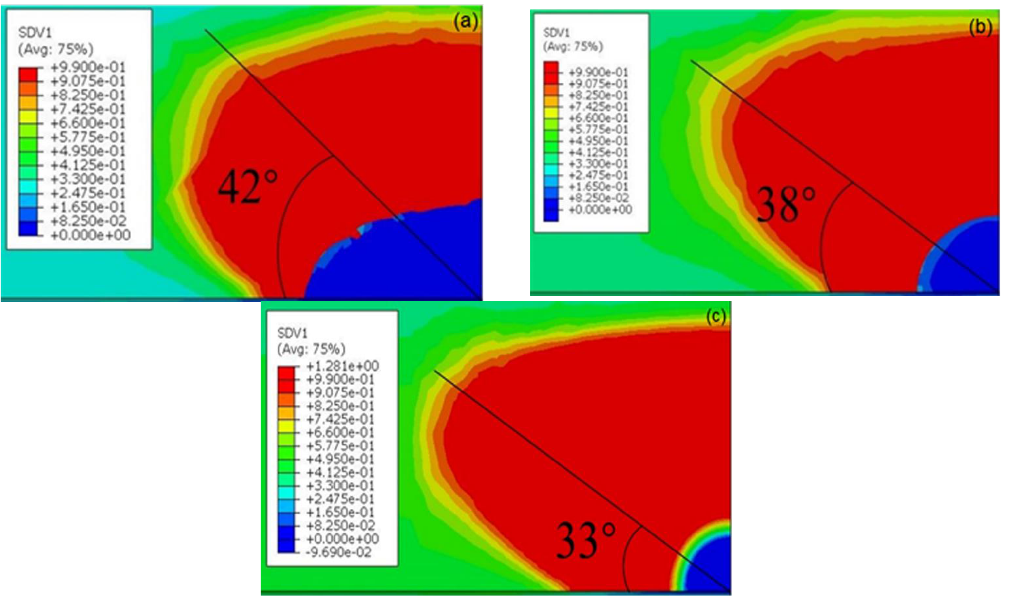
Figure 17. The damage distribution around the creep crack tip ( a ) a 0 /c 0 = 0.5, ( b ) a 0 /c 0 = 0.8 and ( c ) a 0 /c 0 = 1. The creep crack length, the equivalent stress, and the stress triaxiality around the crack tip are shown in Figure 18a – c. The direction angles θ corresponding to the creep crack length, the maximum equivalent stress, and the stress triaxiality are about 42°, 38°, and 33° when a 0 /c 0 is 0.5, 0.8, and 1, respectively. These results coincide with those in Fig- ure 17. Therefore, these results indicate the same creep crack behavior by an axial surface crack with different initial crack shapes a 0 /c 0 .